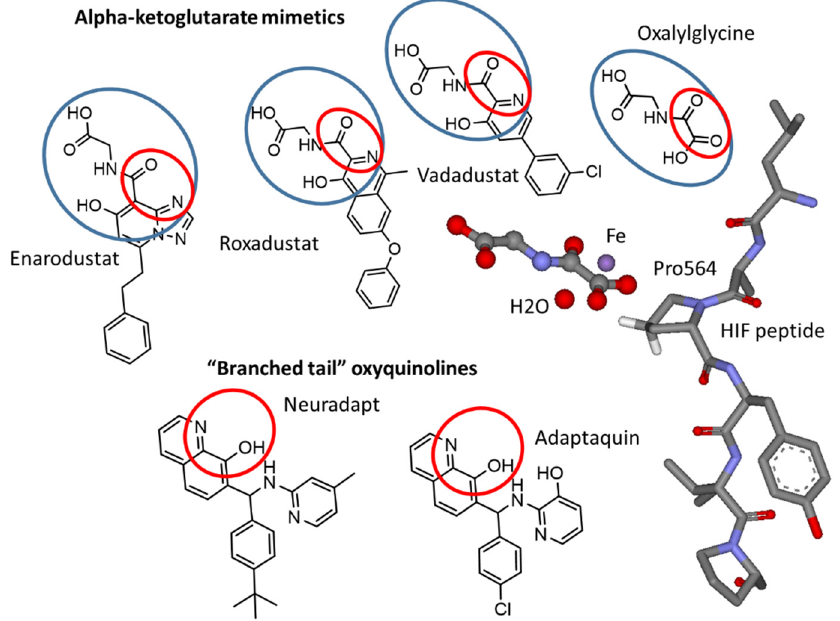
Figure 1. Chemical structures of HIF prolyl hydroxylase inhibitors mimicking α KG (enarodustat, vadadustat, roxadustat, N-oxalyl glycine) and HIF peptide (adaptaquin and neuradapt) binding modes. The oxyquinoline ring provides two iron ligands and the “branched-tails” interfere with HIF peptide binding. Red ovals show iron ligands. Blue ovals show the α KG mimicking part. The arrangement of N-oxalyl glycine (replacing α KG) and HIF peptide with respect to the active site iron in HIF PHD2 (PDB: 3HQR).